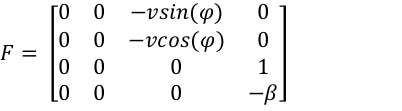
Figure 2. The proposed method to estimate the vehicle's ego- motion.